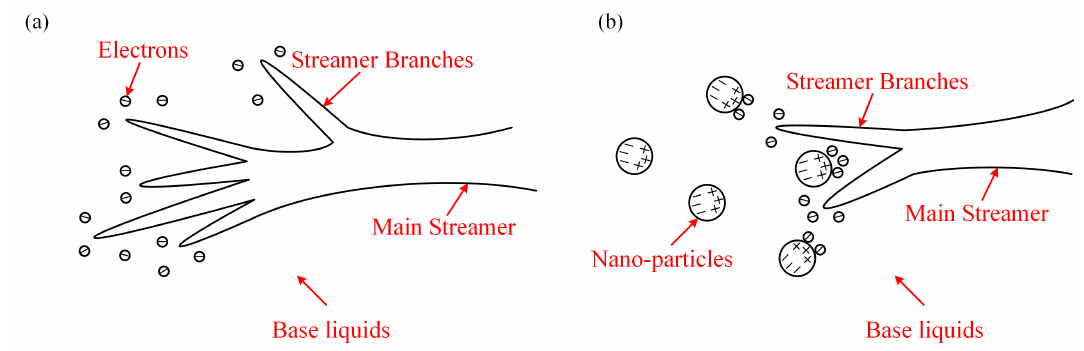
Figure 7. The process of nano-particles trapped electrons in pure transformer oil and nano-liquids. ( a ) Pure transformer oil; ( b )